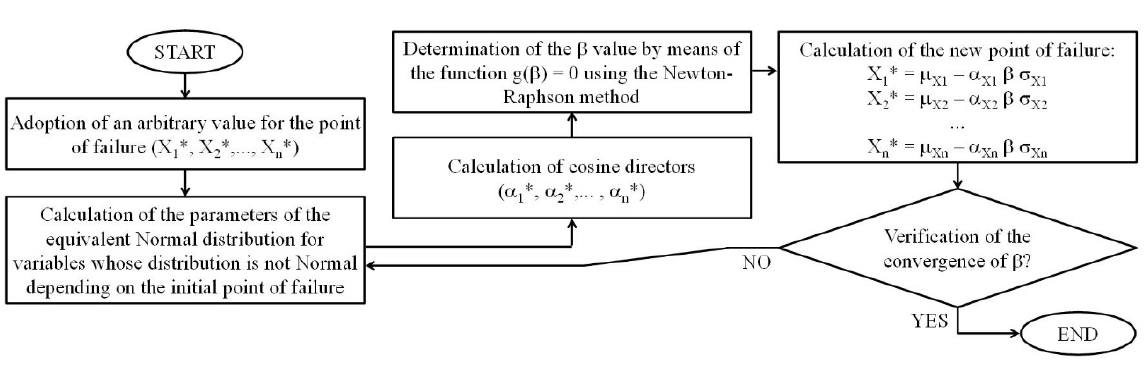
Figure 11. Flowchart of the FORM